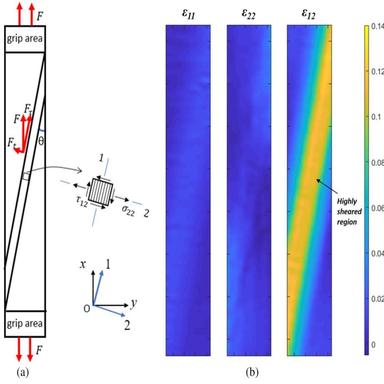
Off-axis tensile test for uncured prepreg – (a) Schematic of test method and (b) Strain fields (ε11/ ε22/ε12) of a specimen in an actual test, obtained through DIC and rotated into the local coordinate system of the fibres. (For interpretation of the references to colour in this figure legend, the reader is referred to the web version of this article.)